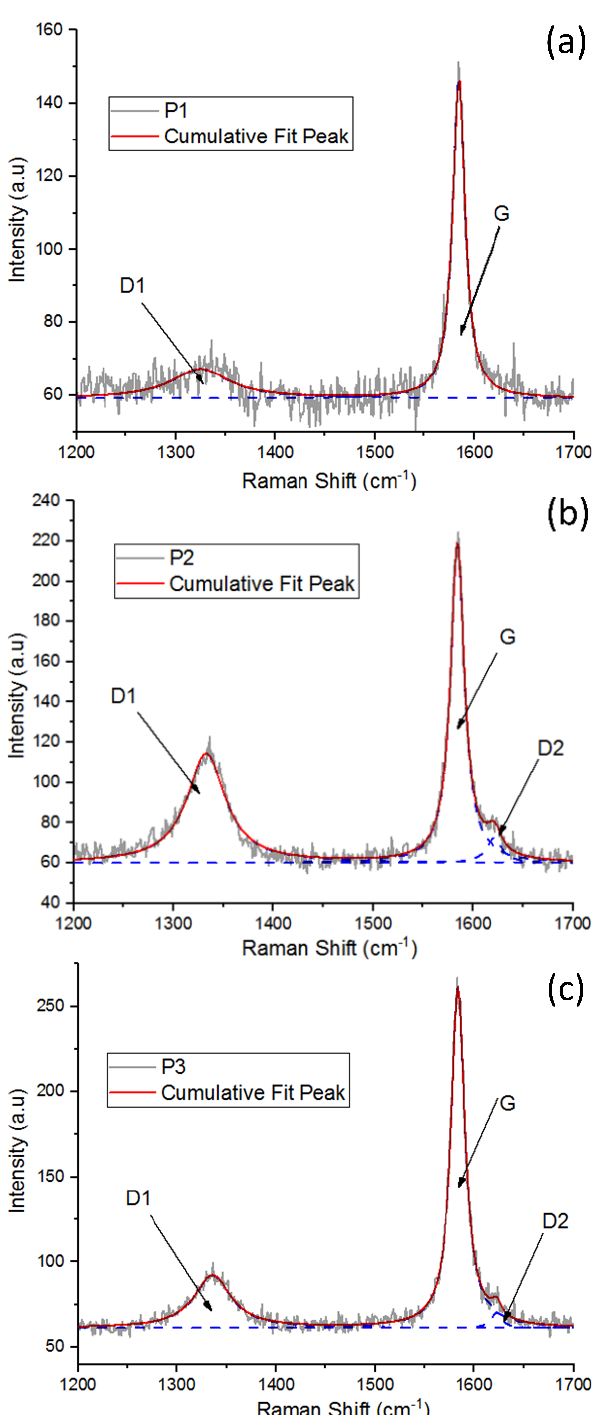
Figure 4: Raman spectra fitting of the (a) P1, (b) P2, and (c) P3 of